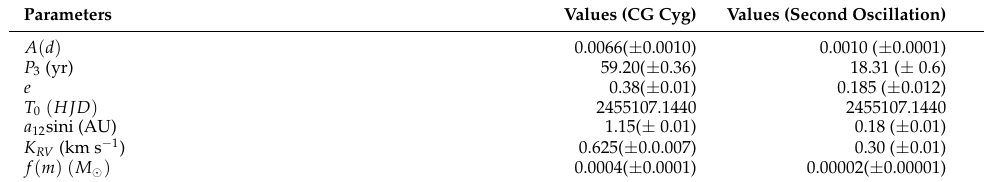
Figure 8. The mass of the third-body for CG Cyg. Table 7. Parameters of the additional bodies of CG